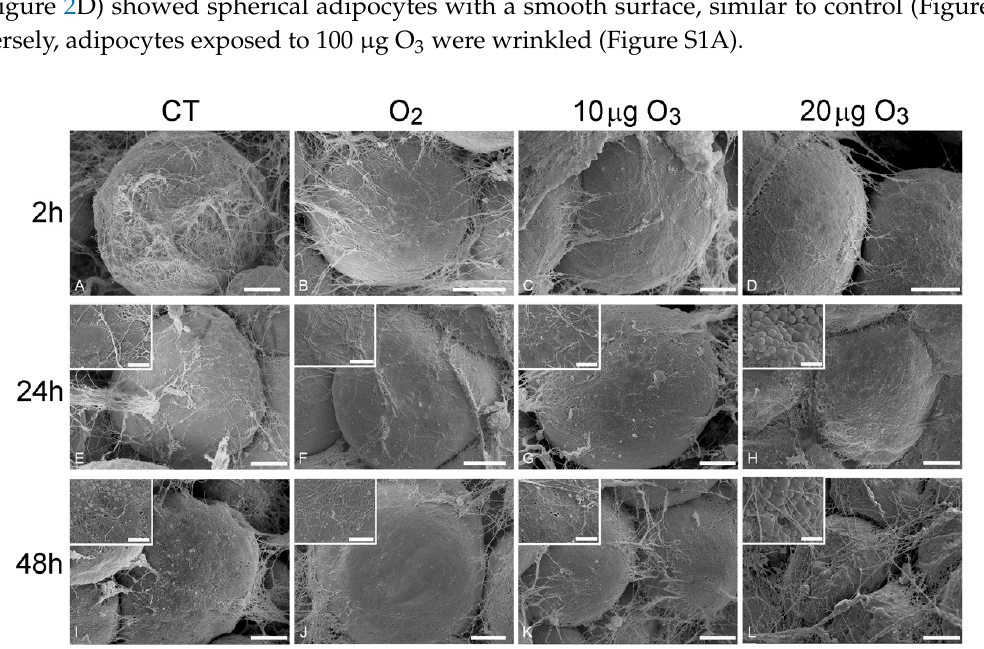
Figure 1. LDH assay on AT samples. Histograms show the mean value ± SE of percentage of tissue viability after 2 h, 24 h and 48 h from the treatment. Statistical di ff erence is indicated by # ( p < 0.05). The value referring to 100 µ g O 3 is statistically di ff erent from all other samples at each time point (* p < 0.001). CT, control.